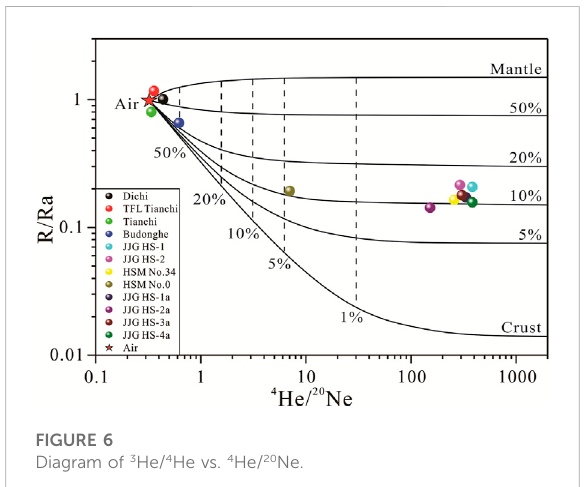
FIGURE 6 Diagram of 3 He/ 4 He vs. 4 He/ 20